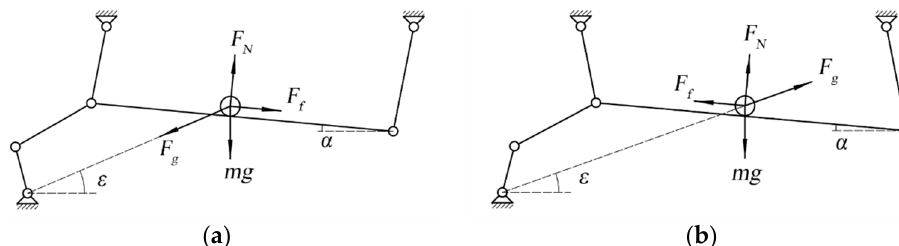
Figure 4. Stress analysis of tiger nut.